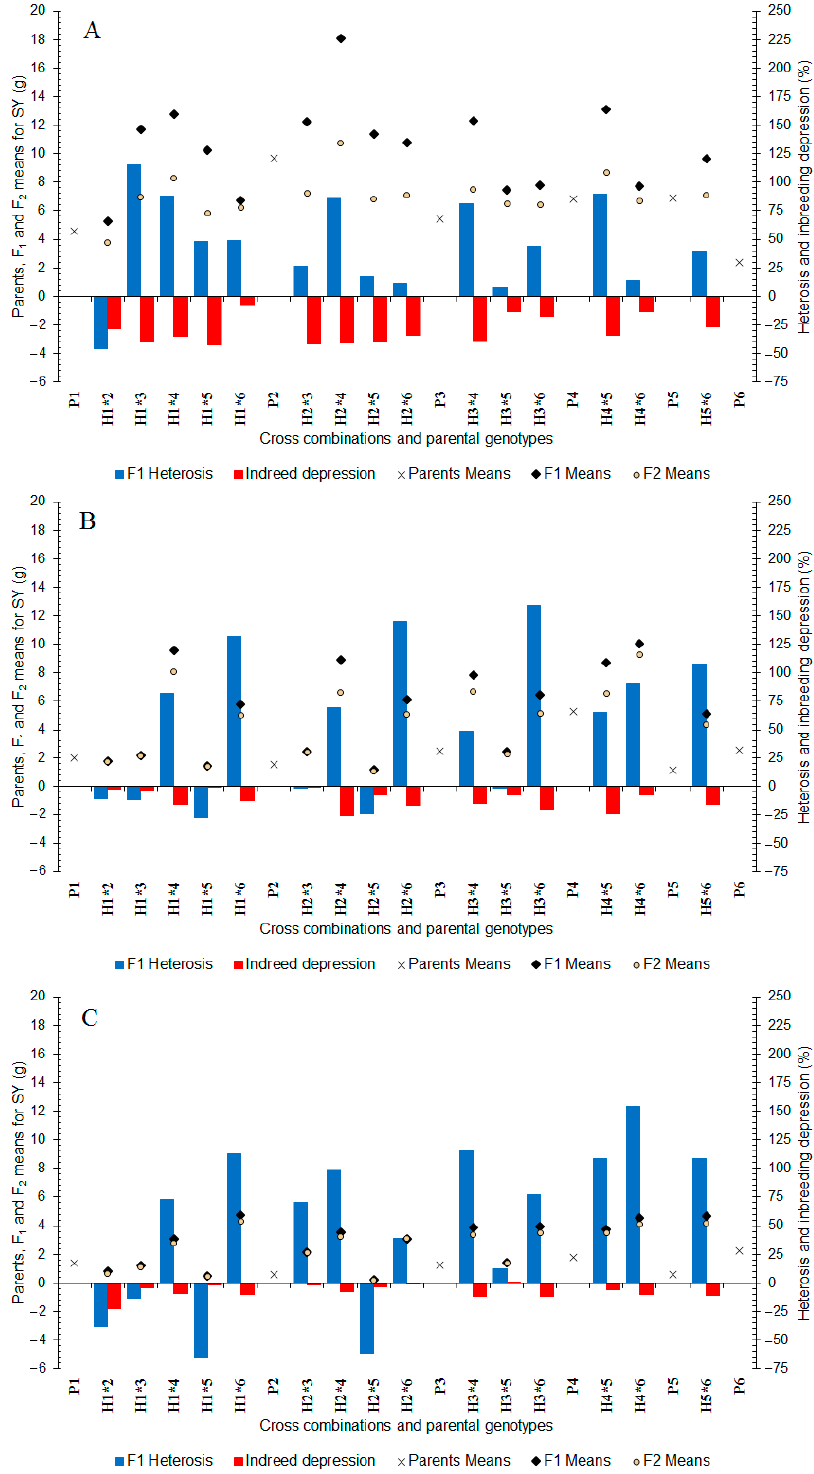
Figure 1. Mean, heterosis, and inbreeding depression for seed yield in F 1 and F 2 generations of coriander crosses. ( A ) Well-Watered, ( B ) Moderate Water Stress, and ( C ) Severe Water Stress. P 1 –P 6 : six parental coriander genotypes; H 1×2 –H 5×6 : 15 half-diallel hybrids. In severe water deficit stress, the seed yield varied from 0.58 (P 5 ) to 2.24 g (P 6 ) between the parents and from 0.22 to 4.77 g between the F 1 hybrids (Figure 1C). In the F 2 generation, seed yield varied from 0.21 to 4.28 g (Figure 1C) and a high seed yield obtained from F